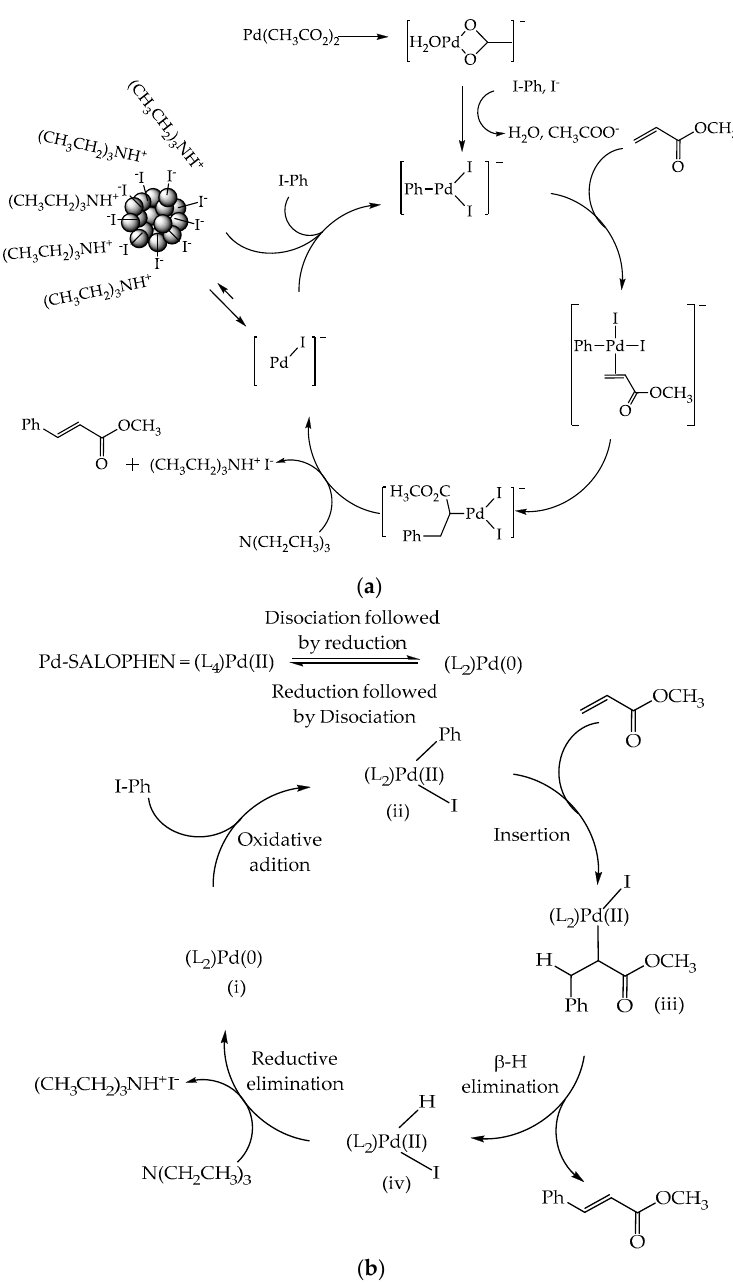
Table 3. I-Ph conversion, time to reach a conversion level of 5%, initial reaction rate (ro) and turnover frequency (TOF) for Pd-based catalysts.